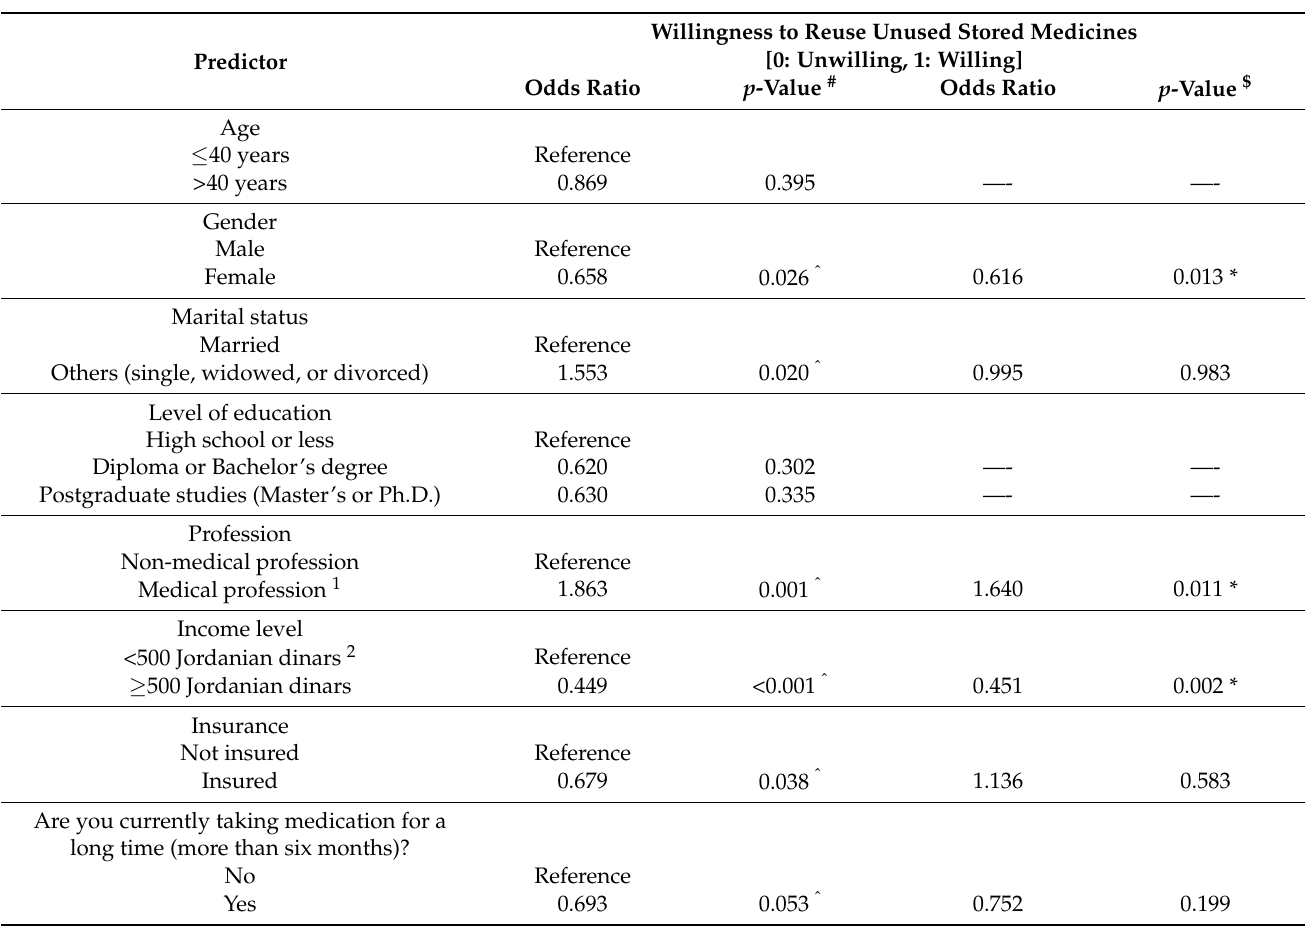
Table 5. Assessment of factors associated with willingness to reuse unused stored